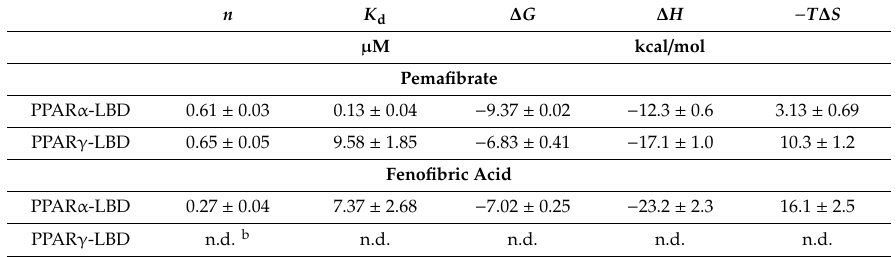
Table 1. Thermodynamic parameters for the interaction between PPARs-LBD (PPAR α -LBD and PPAR γ -LBD) and two fibrates (pemafibrate and fenofibric acid) at 25 ◦ C measured by ITC a . n K d ∆ G ∆ H − T ∆ S µ M kcal / mol PPAR α